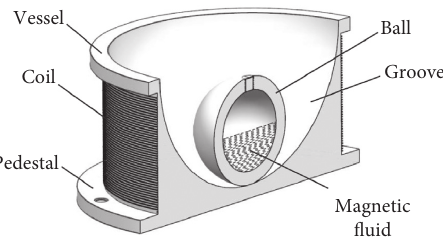
Figure 1: The 3D structure section of the tuned magnetic fluid rolling-ball